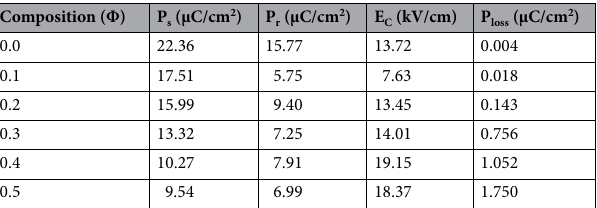
Table 2. Compositional dependence saturation polarization (P S ), remanent polarization (P r ), Co-ercive field (E C ) and P loss obtained after fitting of the P-E loop at RT for the composites.